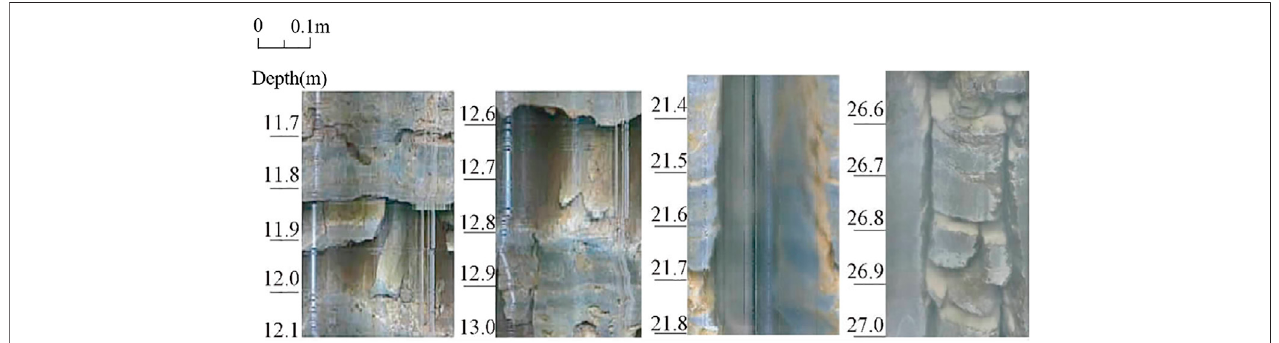
FIGURE 6 | Typical inner photograph of karst fi ssures obtained via the borehole peep method.